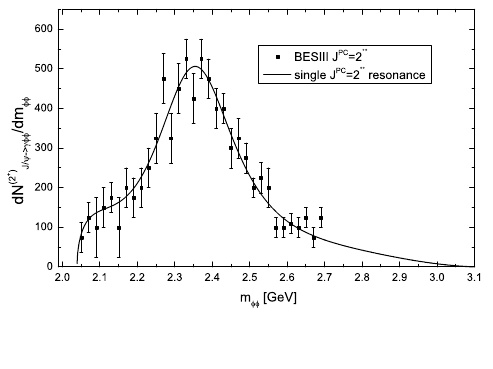
Figure 4. Fitting the 2 +